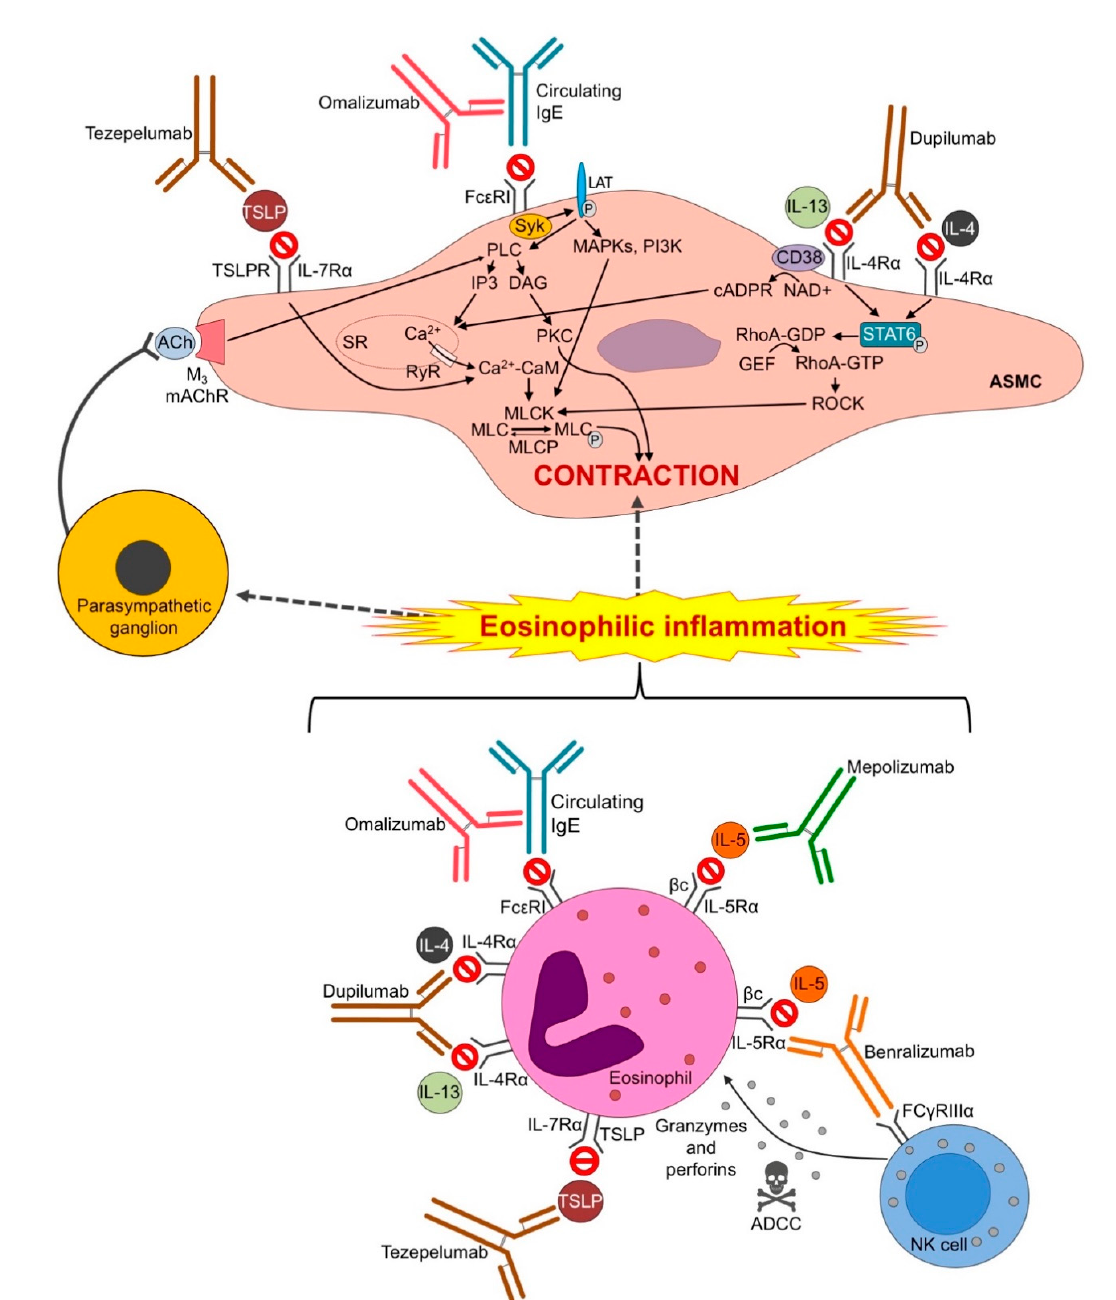
Figure 2. Direct and indirect mechanisms of action against AHR of the mAbs resulting from this systematic review. Parasympathetic ganglia are innervated by preganglionic nerve fibers carried by the vagus nerves and they are found in abundance throughout the walls of medium bronchi. ACh: acetylcholine; ADCC: antibody-dependent cell cytotoxicity; ASMC: airway smooth muscle cell; Ca 2+ : calcium; CaDPR: Cyclic adenosine 5 ′ -diphosphate ribose; CaM: calmodulin; DAG: diacylglycerol; FDA: Food and Drug Administration; GDP: guanosine diphosphate; GEF: guanine nucleotide-exchange factor; IgE: immunoglobulin E; IL-n: interleukin-n; IL-nR: interleukin-n receptor; IP3: inositol trisphosphate; LAT: linker for T-cell activation; mAbs: monoclonal antibodies; MAPK: mitogen-activated protein kinase; mAChR: muscarinic acetylcholine receptor; MLC: Myosin light chain; MLCK: myosin light chain kinase; MLCP: Myosin light chain phosphatase; NAD+: Nicotinamide adenine dinucleotide; NK: natural killer; PKC: protein kinase C; PLC: phospholipase C; RhoA: Ras homolog family member A; ROCK: Rho-associated protein kinase; RyR: ryanodine receptor; SR: sarcoplasmic reticulum; STAT6: signal transducer and activator of transcription 6; TSLP: thymic stromal lymphopoietin; TSPLR: TSLP receptor.